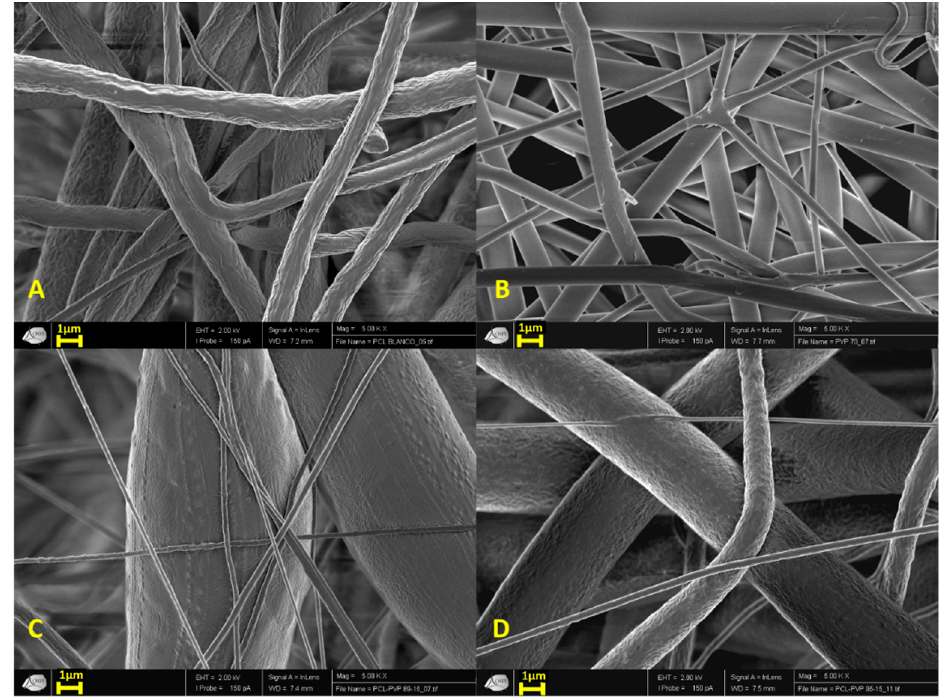
Figure 1. SEM images of ( a ) poly ( Ɛ -caprolactone) (PCL), ( b ) poly (vinyl pyrrolidone) (PVP), ( c ) PCL/PVP 85:15 and ( d ) PCL/PVP 95:5 microfibers scaffold. All micrographs are in 5000 × amplification (scale bar = 1 µm).